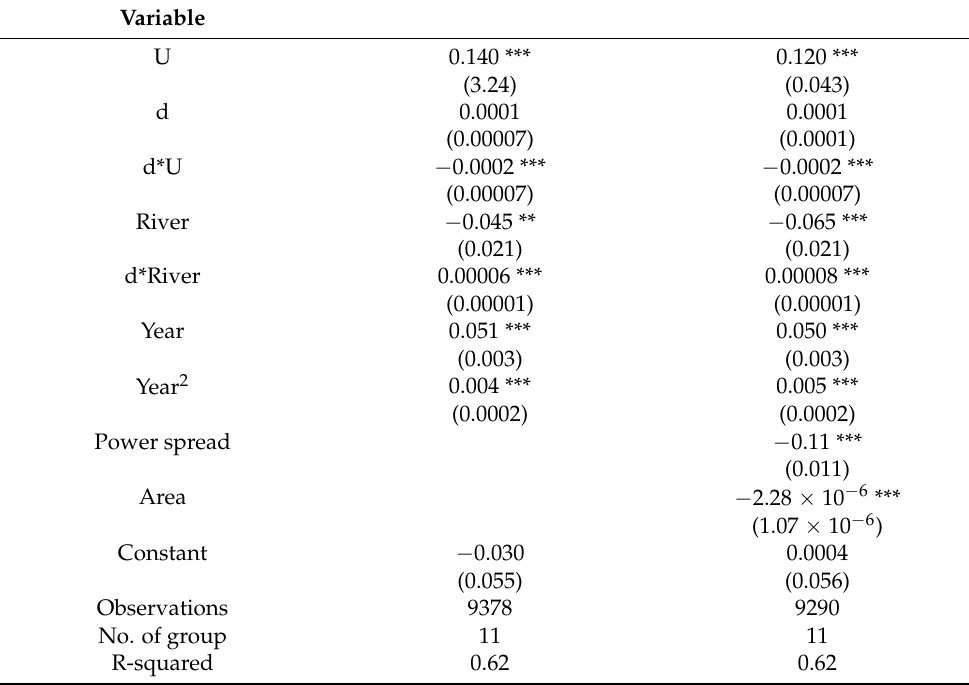
Table 6. Baseline results—the economic impact of building the